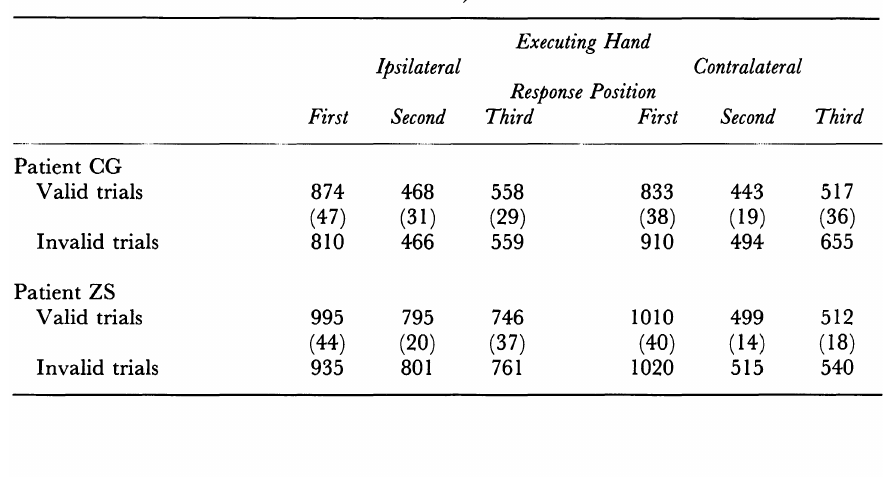
TABLE 2. Response onset time and interkeypress times if patients CG and ZS on valid-invalid trials as function if Response Position and Executing Hand (Standard errors are shown in parentheses for